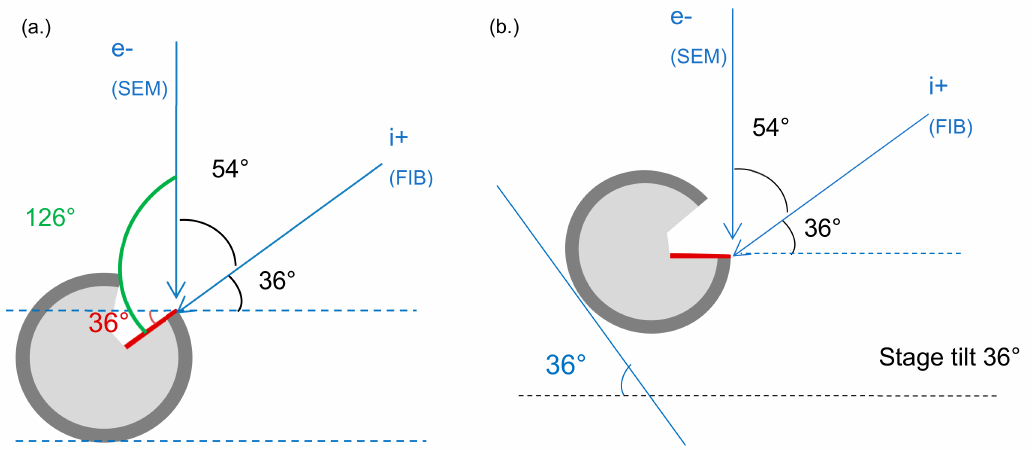
Figure 1. Schematic geometry of ( a ) Dual beam FIB-SEM configuration with particle cross-sectioning process using FIB at 0 ◦ angle stage tilt and ( b ) Cross-section observation at 36 ◦ angle stage tilt using SEM setup.